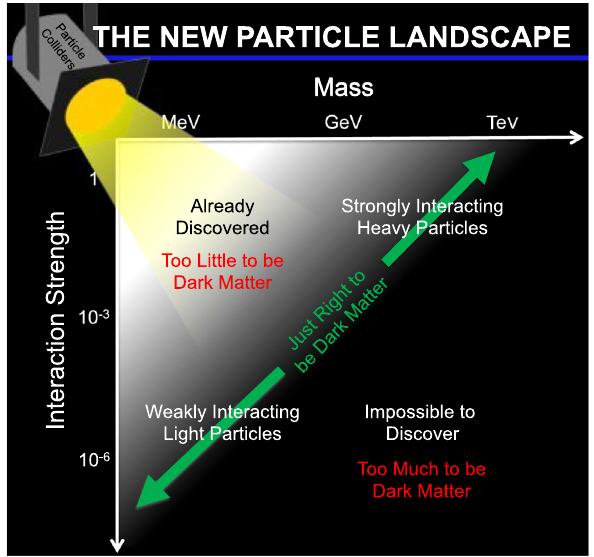
Fig. 29 The new particle landscape. New particles are classified in the ( mass , interaction strength ) plane. Strongly-interacting, light particles have already been discovered, and weakly-interacting, heavy particles are impossible to discover at particle and nuclear accelerator experi- ments. The current frontier therefore lies on the diagonal that contains strongly-interacting, heavy particles and weakly-interacting, light par- ticles. Remarkably, this diagonal is also motivated by thermal relic dark matter and the WIMPless miracle [100,101], and the X17 anomalies are naturally explained by weakly-interacting, light particles that lie in this same diagonal swath of parameter